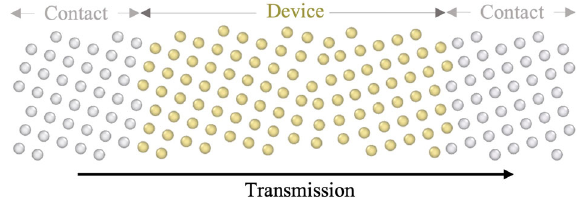
Fig. 7 The model set up in Green ’ s function calculations. The contact regions are the unit layers fi xed during the annealing